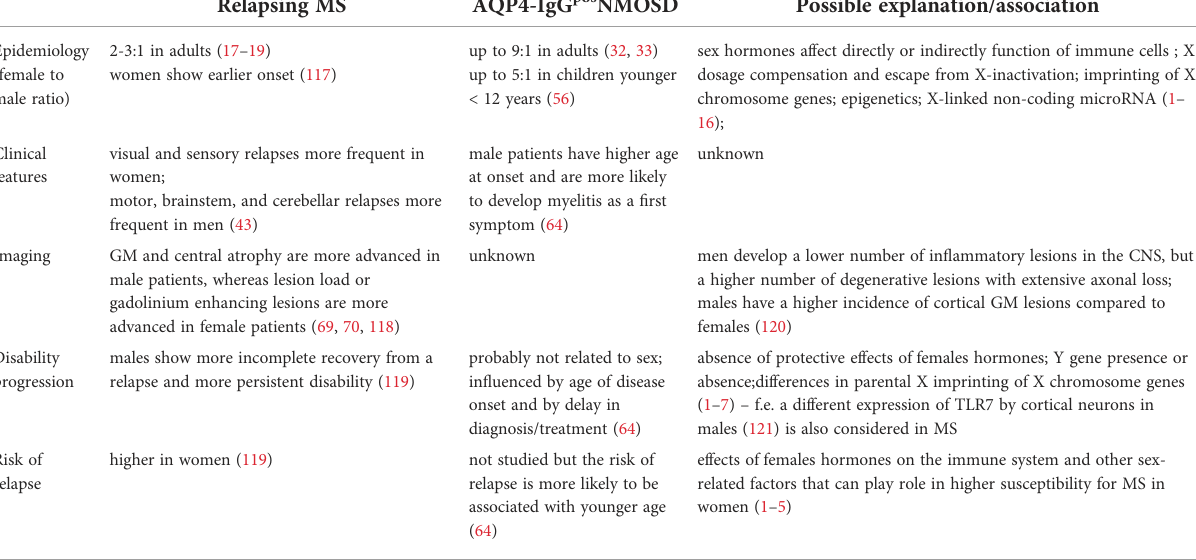
TABLE 1 Summary of sex bias in relapsing multiple sclerosis (MS) and AQP4-antibody seropositive neuromyelitis optica spectrum disorders